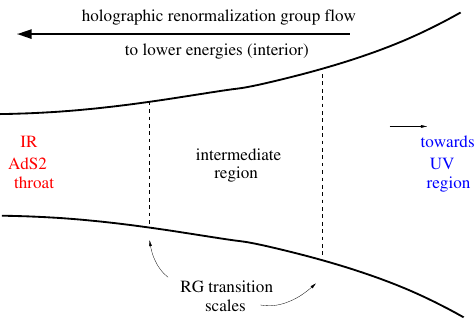
Figure 1 . A cartoon of the bulk spacetime with the holographic RG (cid:13)ow in the radial direction to the infrared AdS 2 throat region from the far (UV) region through possible intermediate regions (and associated RG transition